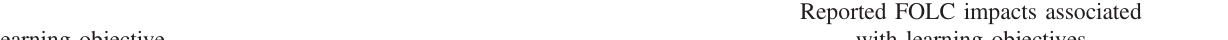
TABLE VII. Connections between NFW-FOLC learning objectives and the reported impacts of participating in the FOLC. Learning objective Develop reflective teaching habits and a dedication to continuous improvement of